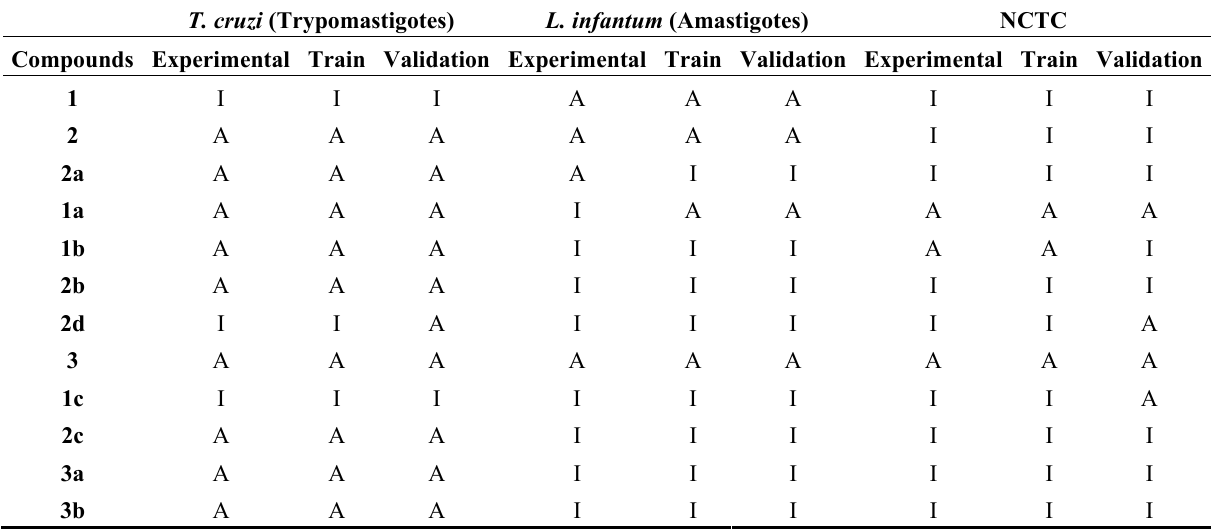
Table 2. Comparison of experimental antileishmanial, antitrypanosomal and cytotoxic activities with data predicted by Decision tree models for the training set and internal cross validation